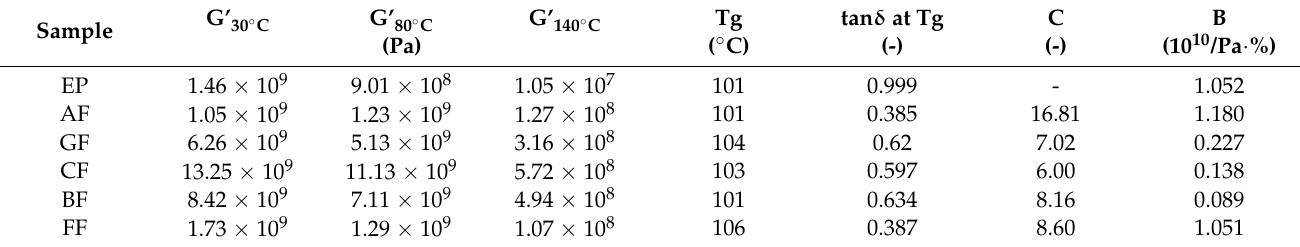
Table 2. Thermomechanical parameters and brittleness of EP-based composites.